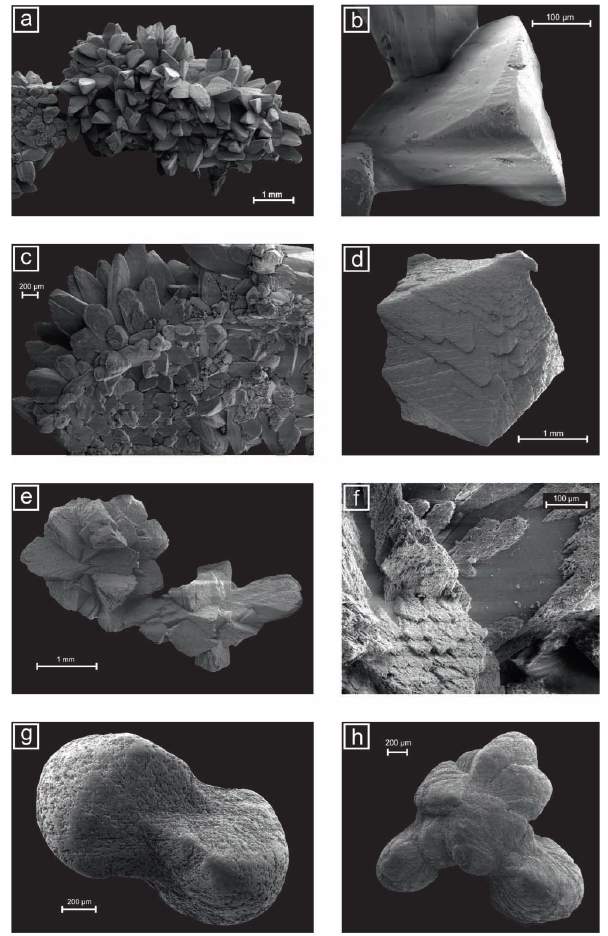
Fig. 4. SEM images of various types of “crystal sand”. (a) Surface of a speleothem platelet (central particle) with translucent rhom- bohedral crystals (acute rhombohedral faces on the flanks, obtuse rhombohedral faces at growth end); particles to the left mark bottom of speleothem platelet. (b) Growth end of a translucent rhombohe- dral crystal with obtuse rhombohedral faces at the apex area of the crystal. (c) Moderately curved bottom of a speleothem, platelet with translucent rhombohedral crystals. (d, e) Aggregates and individu- als of crystals with rhombohedral faces (whitish to buff-colored) without acute rhombohedral faces but with distinct domain devel- opment; d = single crystals, e = chain. (f) Partial overgrowth of translucent aggregates and individuals of crystals with rhombohe- dral faces (type a; smooth surfaces) by aggregates and individuals of crystals with rhombohedral faces (type b) with a distinct domain growth. (g) Dumbbell-shaped spherulithic crystal aggregates. (h) Braided-shaped spherulitic aggregates.